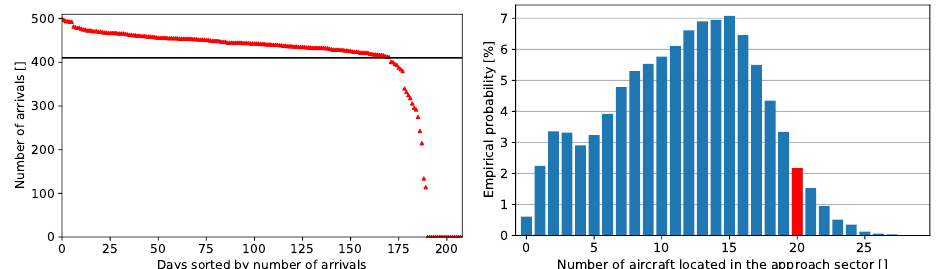
Figure 4. Left : Number of arriving flights at WSSS. Right : Approach sector capacity